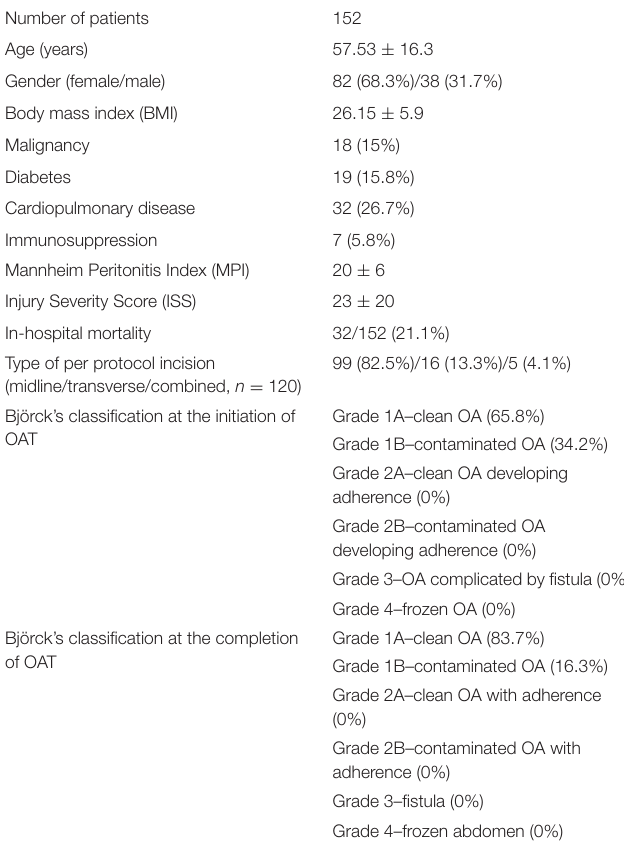
TABLE 1 | Patients